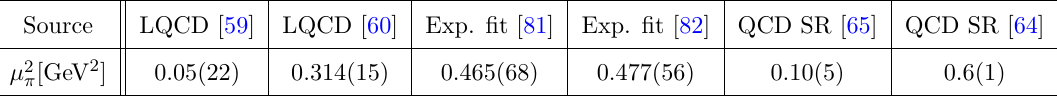
( B ) available in the π